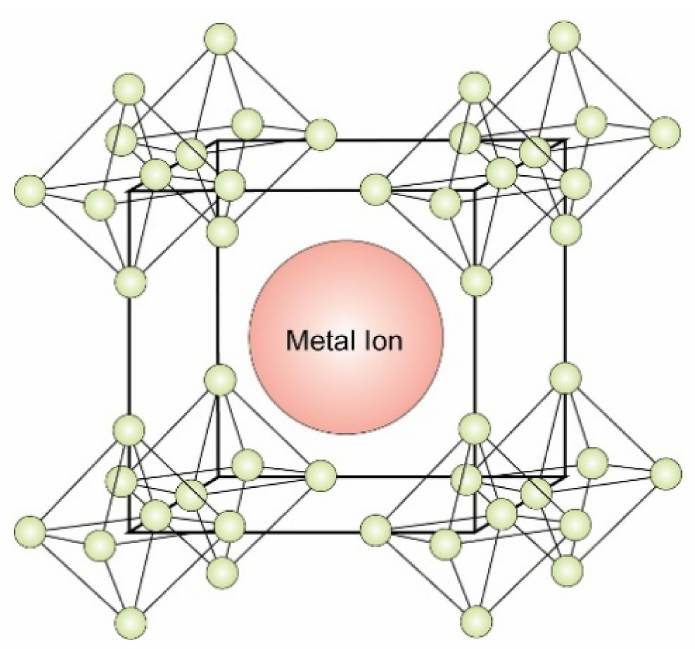
Figure 1. Alkaline-earth hexaboride example of crystal structure (CaB 6 )